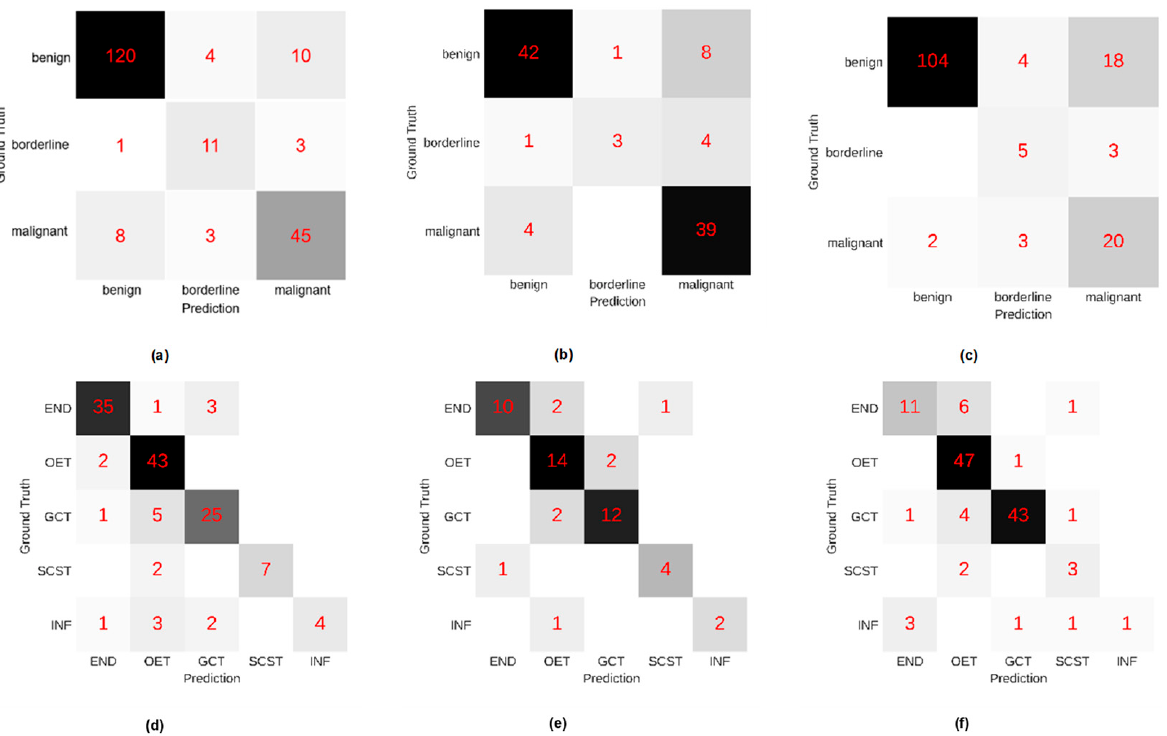
Figure 4. Confusion matrixes of the type classifier for ( a ) the internal validation dataset, ( b ) external test dataset 1, and ( c ) external test dataset 2. Confusion matrixes of the pathological subtype classifier for ( d ) the internal validation dataset, ( e ) external test dataset 1, and ( f ) external test dataset 2. The lateral axis represents the predictive result of the type classifier or the pathological subtype classifier; the vertical axis represents the ground truth (pathological diagnosis) of the adnexal masses. END: endometriosis; OET: other epithelial tumors except endometriosis; GCT: germ cell tumors; SCST: sex cord-stromal tumors; INF: inflammation.